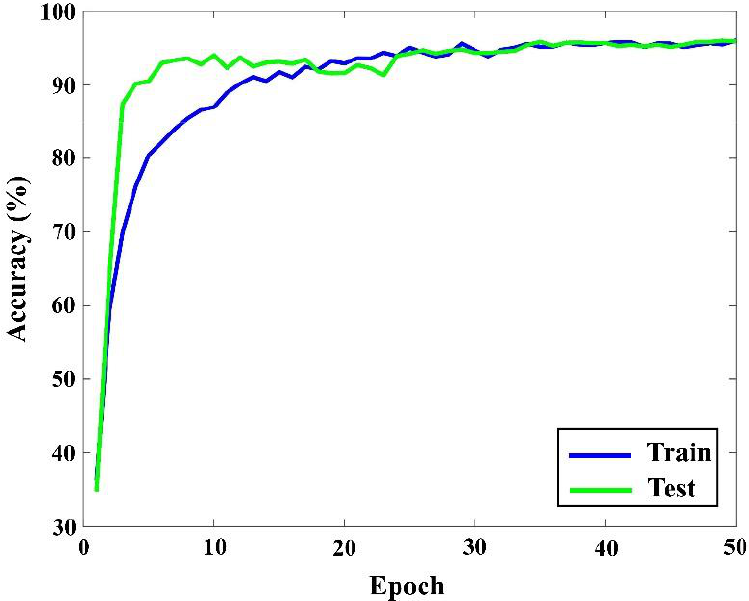
Figure 8. The field data accuracy varies with epochs using the dual-channel CNN.